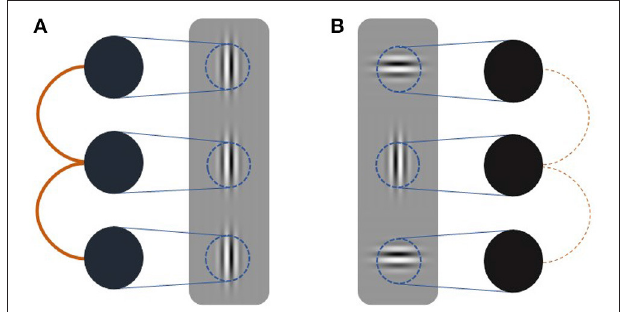
FIGURE 2 | Schematic of simulation setup. Three oscillators (black circles) receive input (blue lines) dependent on the contrast presented in their receptive fields (blue circles). Coupling strength (orange lines) is dependent on the relative orientation of the target and flanker Gabor patches. Thick solid lines indicate strong coupling whereas thin dashed line indicate weak coupling. (A) Coupling between oscillators receiving collinear inputs is strong. (B) Coupling between oscillators receiving orthogonal input is